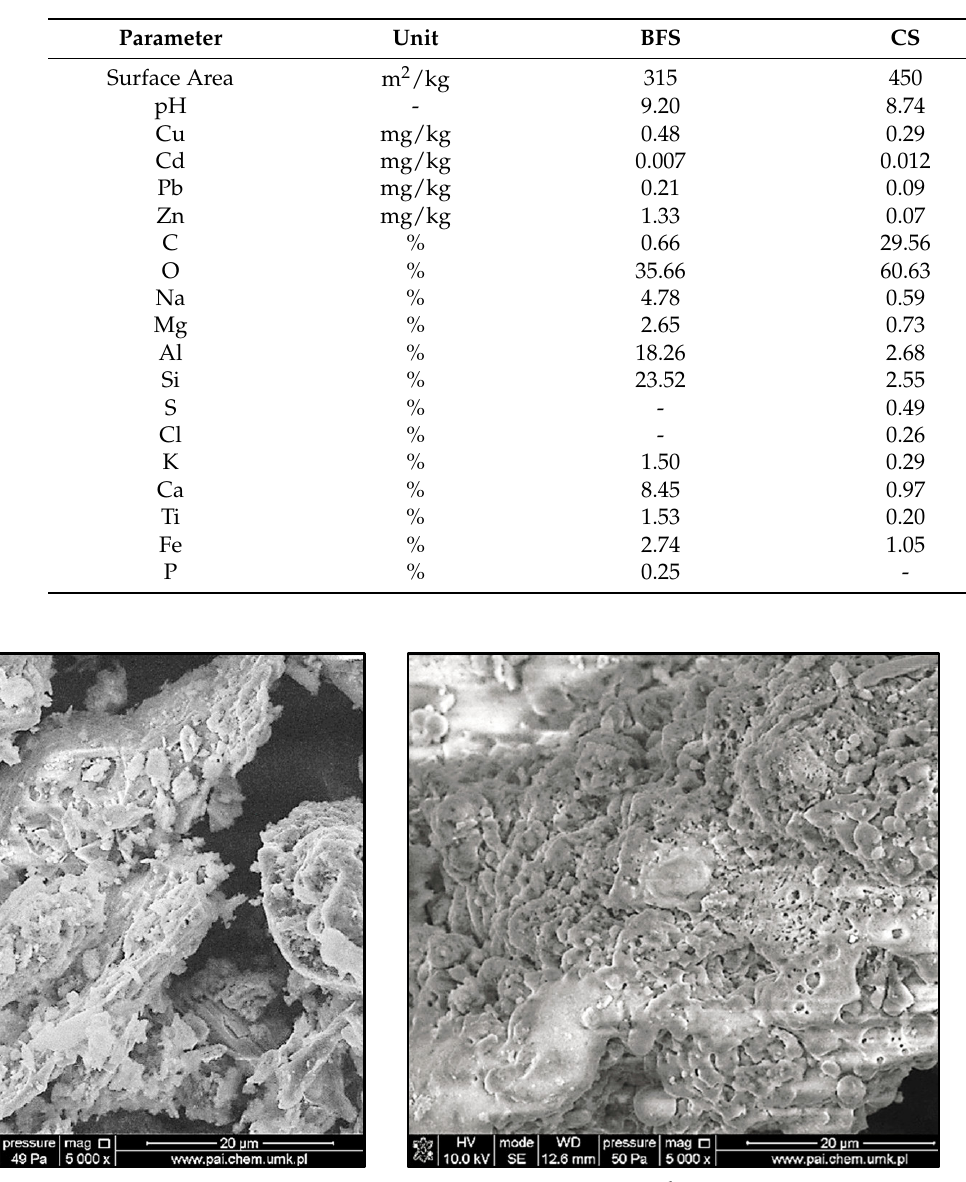
Table 1. Physicochemical composition of blast furnace slag (BFS) and coal slag (CS) used in the experiment.